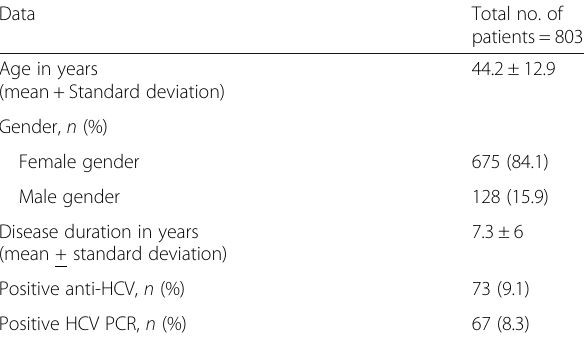
Table 1 Demographic data and medical status of the patients